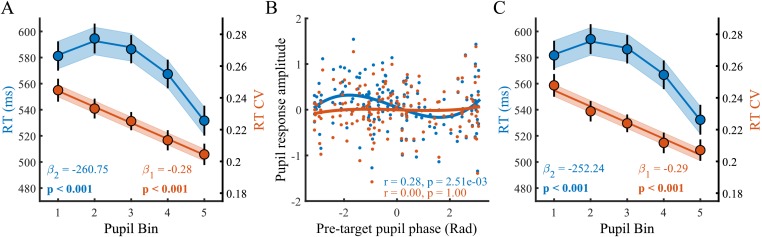
The effect of baseline pupil diameter on the relationship between the pupil response and behavioural performance.(A) Behavioural performance binned by the size of the phasic pupil response to target onset without removing the trial-to-trial fluctuations in baseline pupil diameter. (B) The relationship between the pre-target phase (radians) of the pupil diameter, and the amplitude of the post-target pupil response, before (blue) and after (red) the regression procedure for an example subject. Dots denote individual trials, lines indicate third order polynomial fits to the data. (C) As in A, but without the removal of the trial-to-trial fluctuations due to fluctuations in the phase of the baseline pupil diameter. Error bars and shaded regions denote ±1 standard error of the mean (SEM). Stats, linear mixed effects model analyses and the circular correlation coefficient (Statistical analyses).